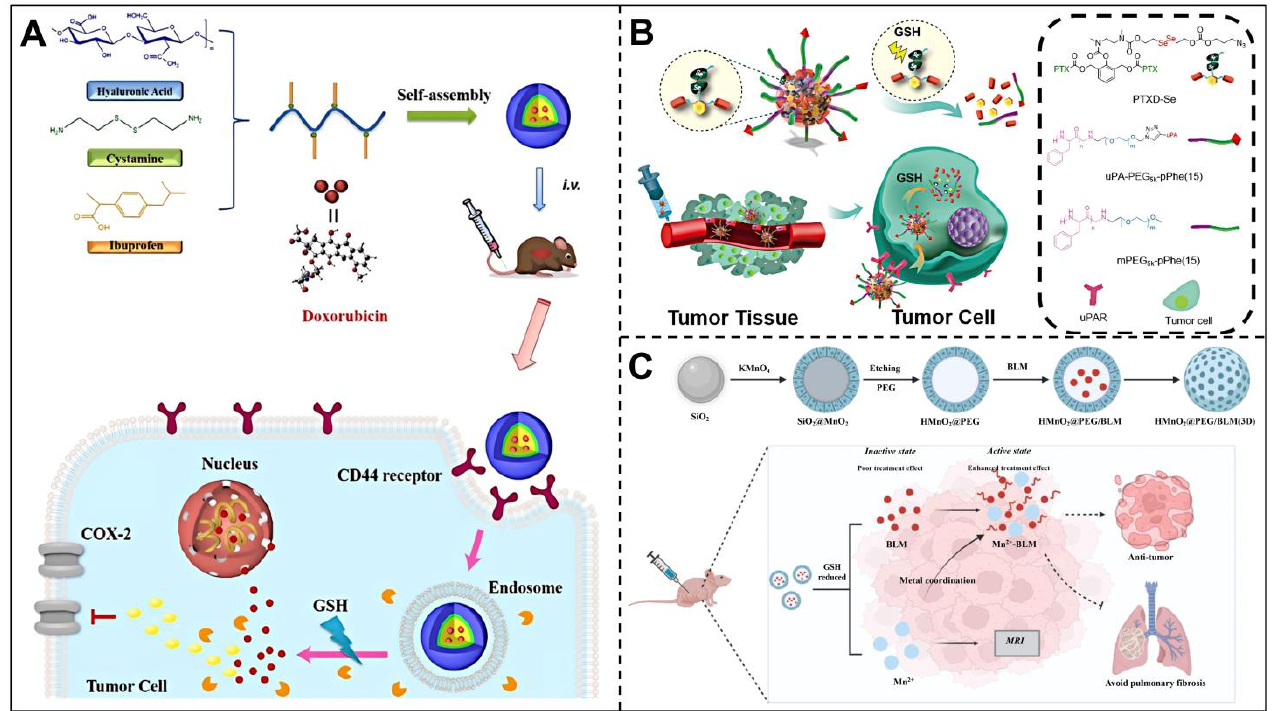
Figure 3. Design and responsive mechanism of GSH-triggered srNPs. ( A ) Preparation and in vivo release mechanism of HA-ss-BF. Reproduced with permission [88]. Copyright 2020, Elsevier. ( B ) Schematic showing composition and GSH-triggered drug release of uPA-PTXD NPs. Reproduced with permission [91]. Copyright 2018 Ivyspring International Publisher. ( C ) Diagram illustrating formulation and application of HMnO@PEG/BLM. Reproduced with permission [96]. Copyright 2022, American Chemical Society.